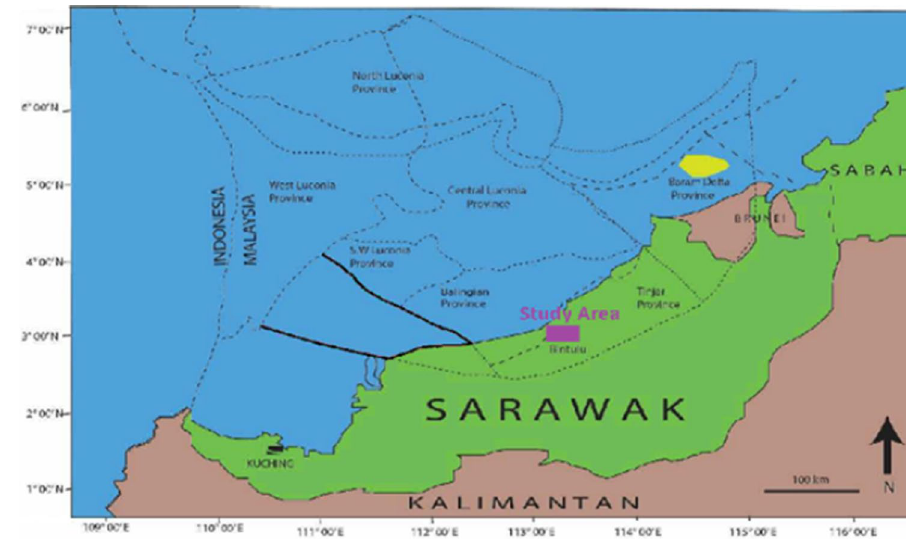
Fig. 1 Location map of the study area modified after Iqbal et al.